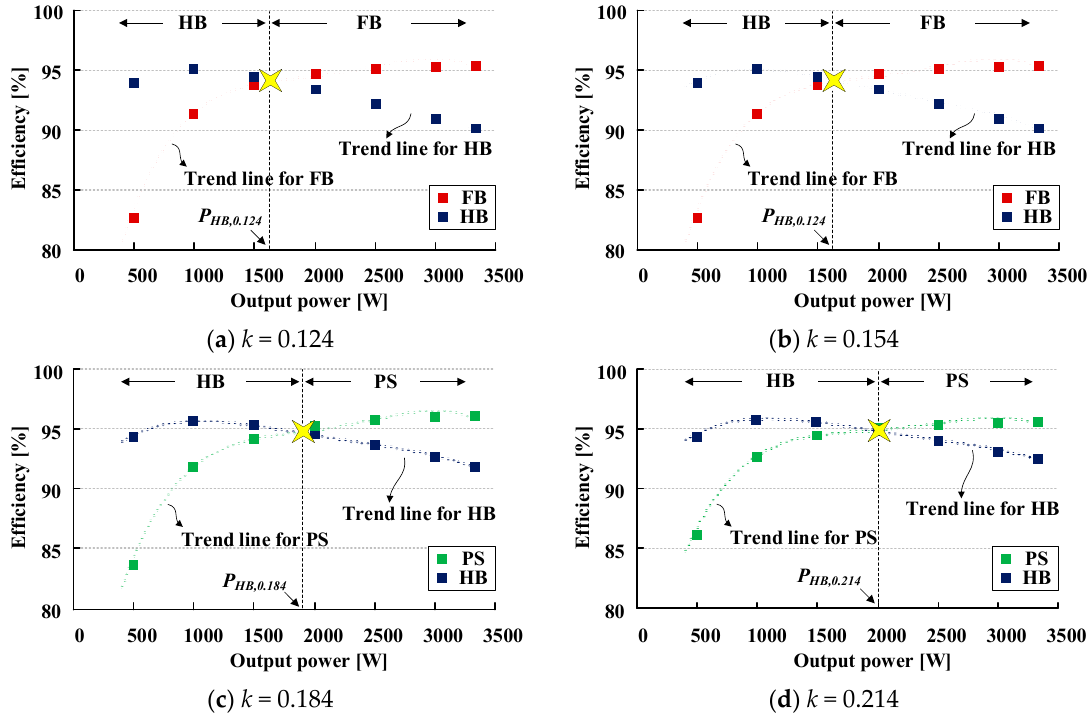
Figure 4. Numerical efficiency graphs for the control modes and efficiency crossing points.